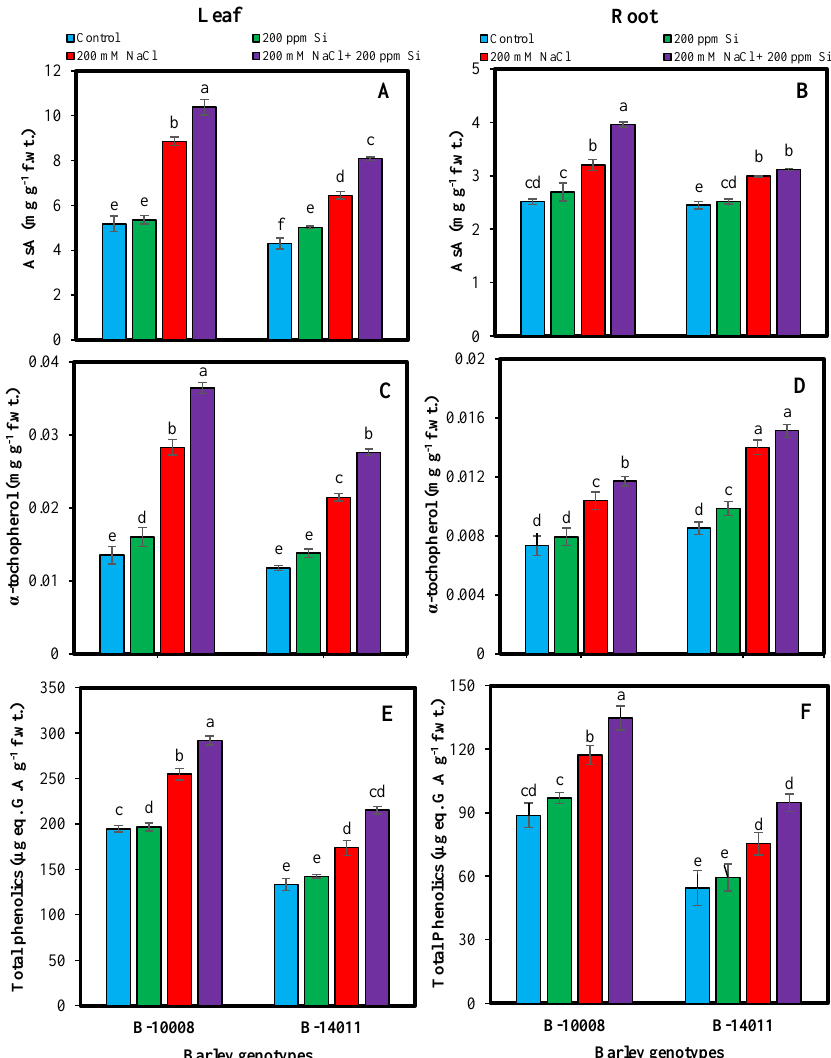
Figure 4. Ascorbic acid (AsA) ( A , B ) (mg g − 1 f.wt.), α -tocopherol ( C , D ) (mg g − 1 f.wt.) and total phenolics ( E , F ) ( µ g eq. GA g − 1 f.wt.) contents in leaf and root of barley genotypes modulated by application of silicon through rooting media under salinity stress. The values represented by bars are means of four replicates ± SE. Different small letters (a–e) on bars denote significant difference at p ≤ 0.05 (Duncan’s multiple range test). Values sharing same letter within each subfigure are non-significant statistically.